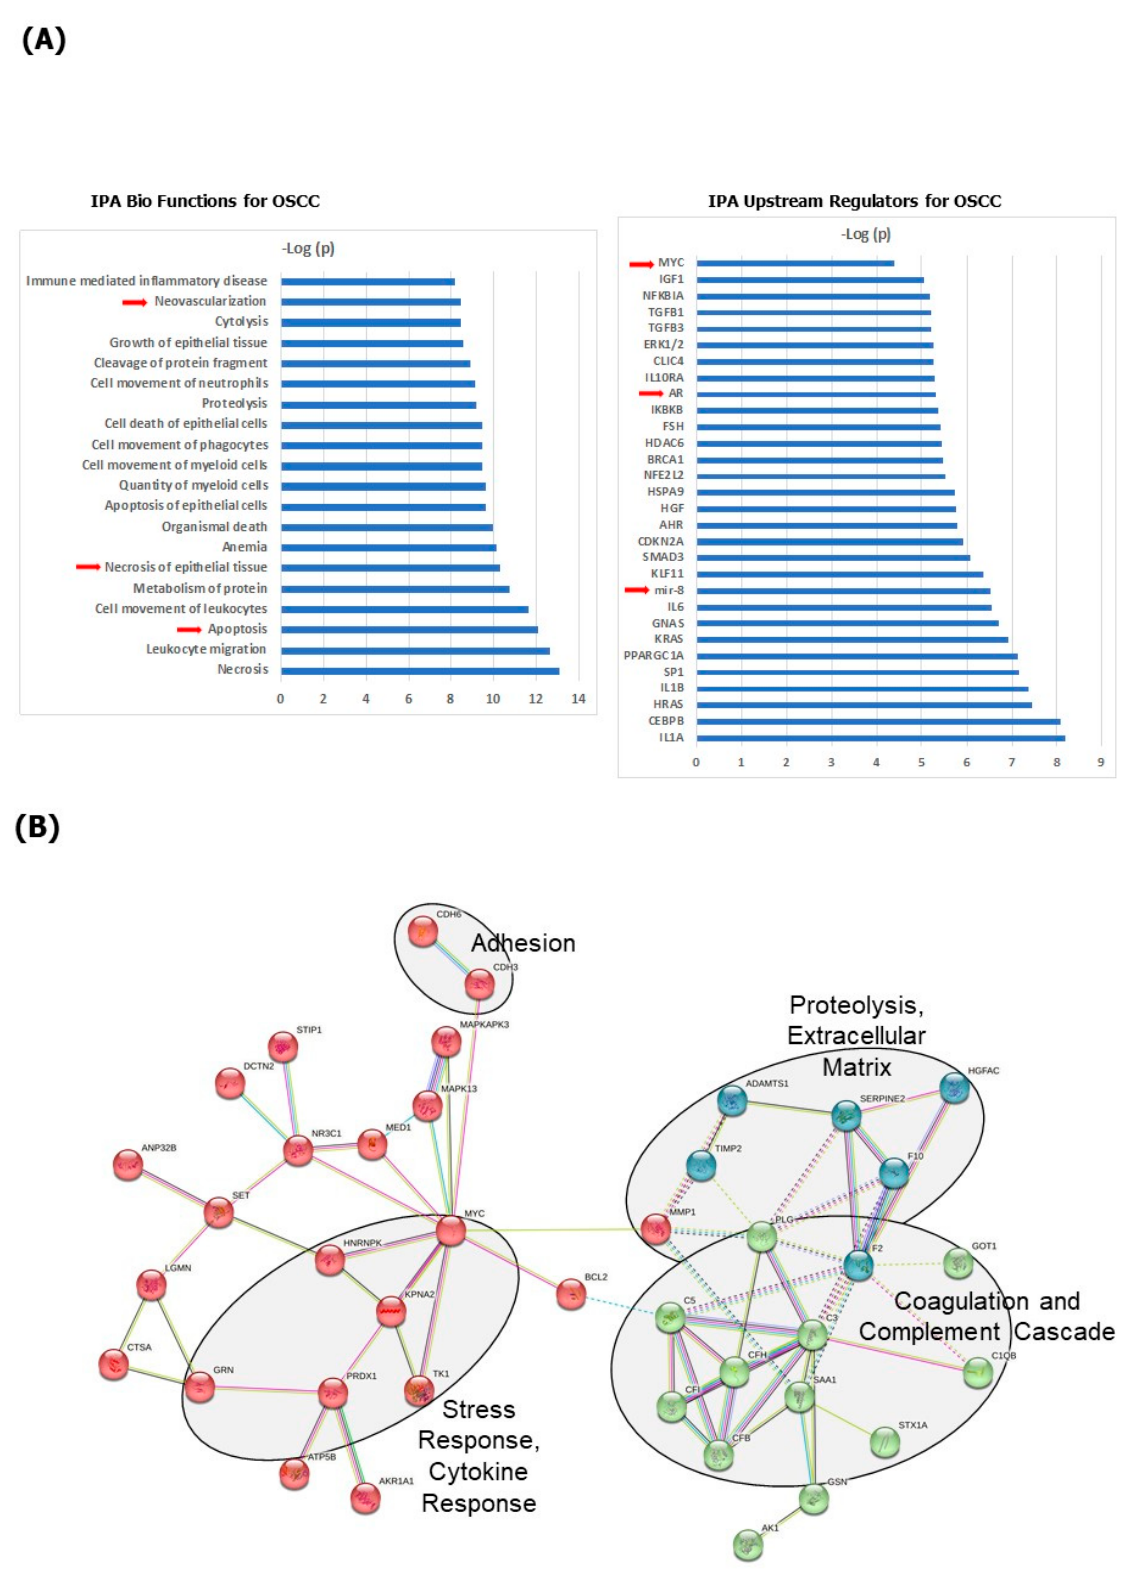
Figure 2. Systems biology analysis of 63 OSCC-associated proteins. ( A ) Biological functions that are significantly enriched by the input 63 protein list ( left panel); upstream regulators that best explain the observed expression changes in OSCC ( right panel); ( B ) Network and cluster analysis using the STRING database of functional and physical protein associations.